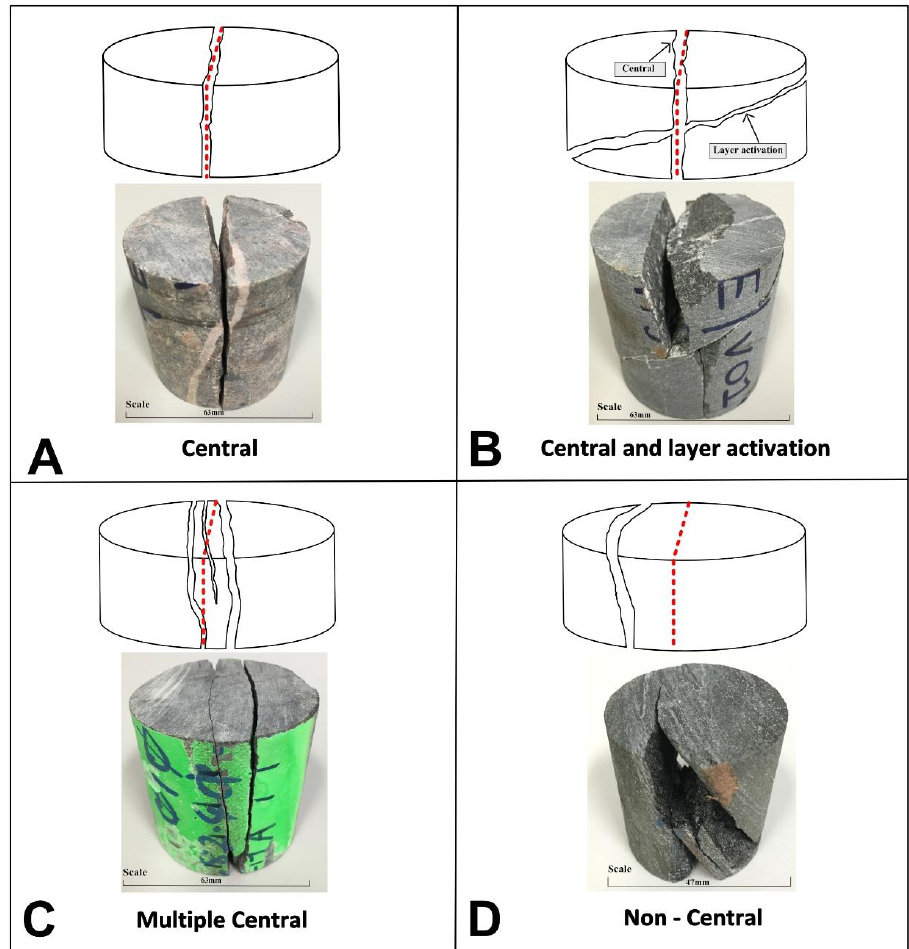
Figure 6. Photographs and schematic drawings showing the failure modes observed during the ITS tests. Red dashed lines indicate planes parallel to the maximum principal stress. ( A ) Example of central failure where the fracture is parallel to maximum principal stress; sample TE/BO3. ( B ) Example of failure by central fracture and layer activation. The fractures are sub-parallel and at high angles to the maximum principal stress; sample TE/VO1. ( C ) Example of failure along multiple central fractures. The fractures develop sub-parallel to the maximum principal stress; sample TE1A. ( D ) Example of non-central failure. The fracture is independent of the maximum principal stress and follows pre-existing planes of weakness; sample TE/FO3.